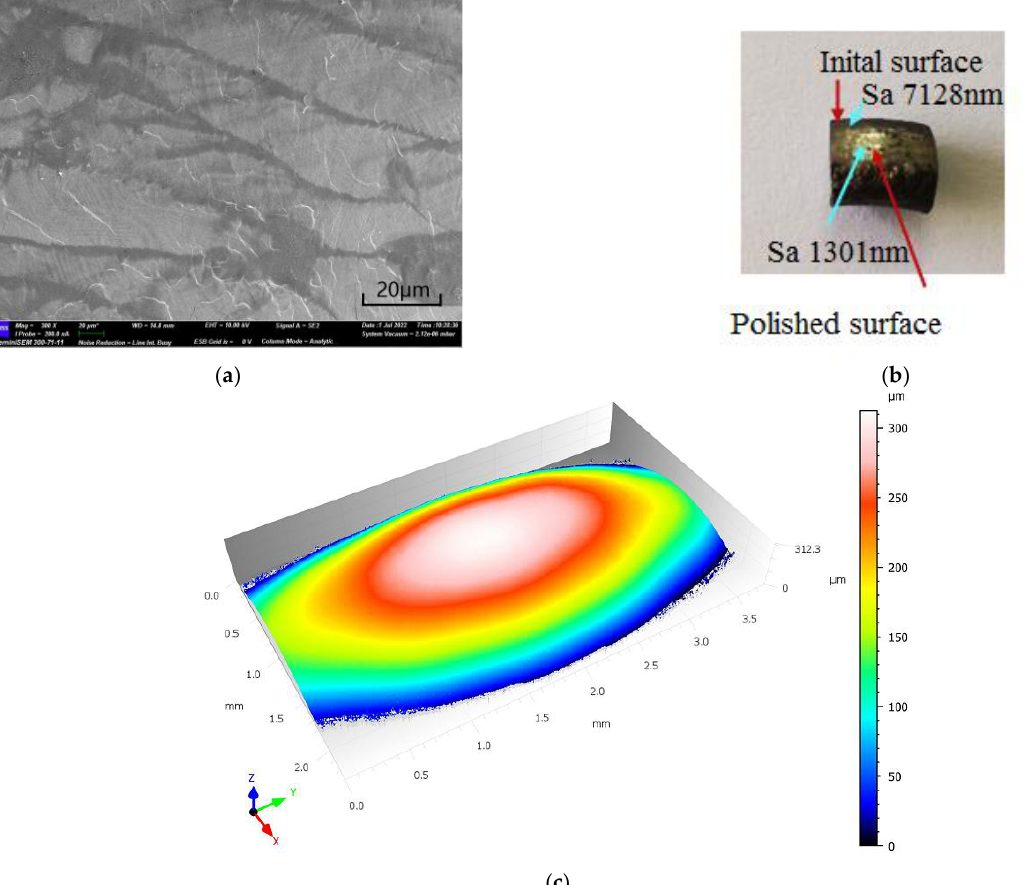
Figure 13. Polished specimen C ’ and surface morphology of area C ’ . ( a ) SEM images of Part C ’ ; ( b ) Polished specimen C ’ ; ( c ) 3D profiles of C ’ .